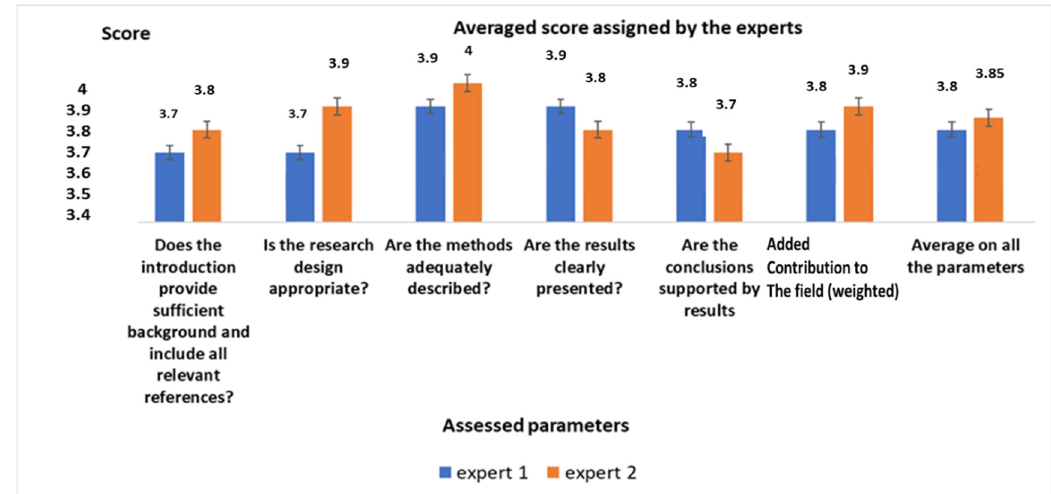
Figure 1. Output from the qualification process.